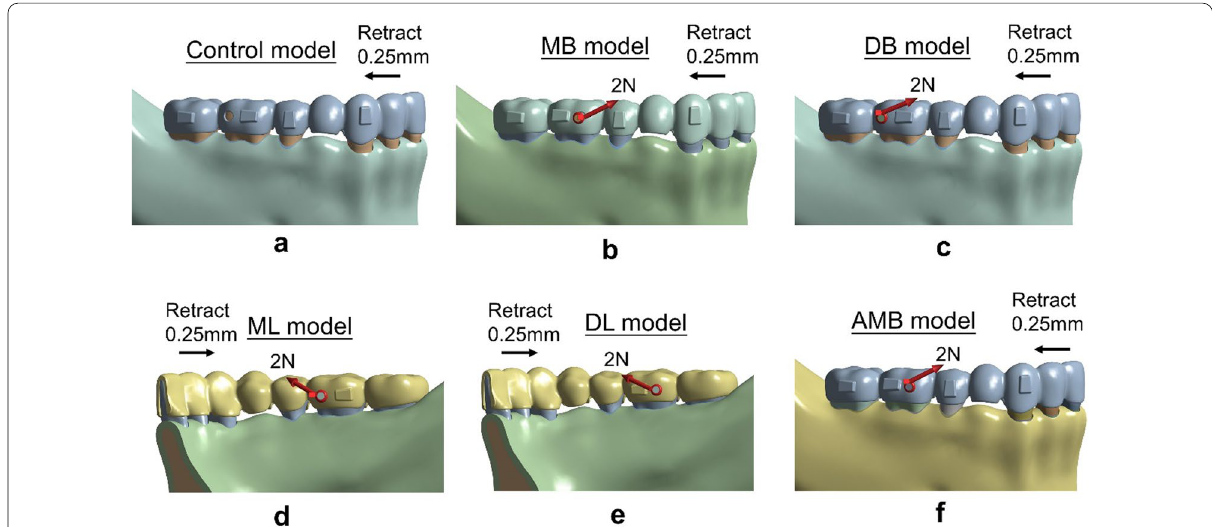
Fig. 2 Six models. a The control model, b the MB model, c the DB model, d the ML model, e the DL model, and f the AMB model